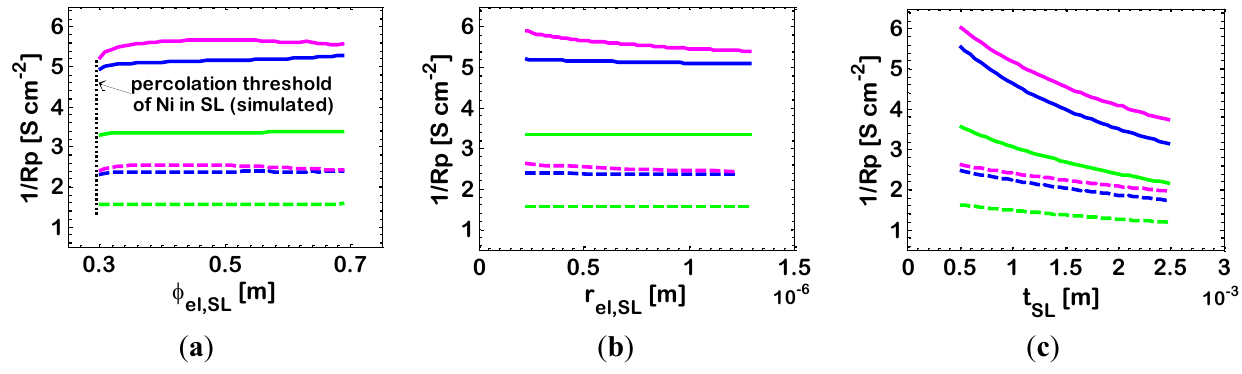
Figure 9. Effect of SL characteristics on the 1/R of bi-layered Ni-YSZ anodes operating at p temperatures: T = 973 K (dashed lines) and T = 1073 K (solid lines). Other data are reported in Table 2. Varying parameter: Ni volumetric fraction in the AL: Case 2 (ϕ = 0.34); Case 2 (ϕ = 0.44); and Case 2 el,AL c el,AL Simulations results of the impact of: ( a ) SL Ni volumetric fraction (ϕ dimensions ( r = r ); and ( c ) SL thickness ( t el,SL io,SL SL